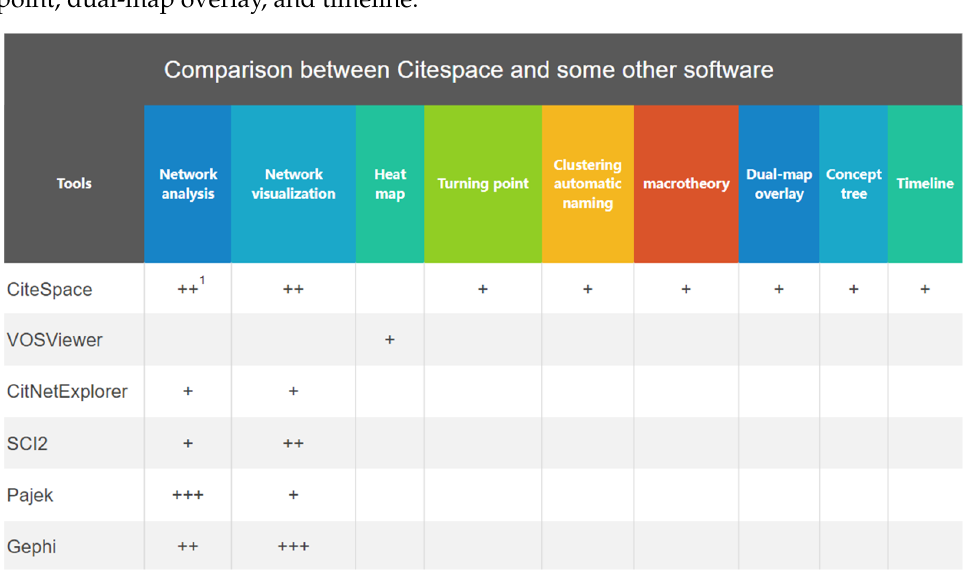
Figure 2. Comparison between CiteSpace and other software packages. 1 Note. +, ++, and +++ indicate that the software is weak, medium, and strong in the application field, respectively.